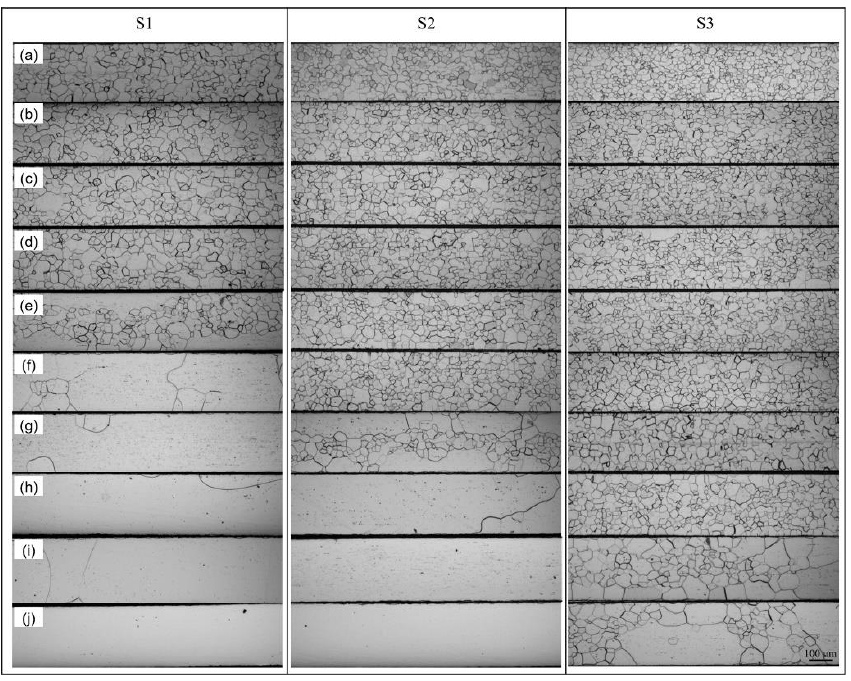
Figure 1. The metallography of the extracted samples during high temperature annealing. ( a ) 25 °C, ( b ) 850 °C; ( c ) 900 °C; ( d ) 980 °C; ( e ) 1000 °C; ( f ) 1010 °C; ( g ) 1020 °C; ( h ) 1030 °C; ( i ) 1040 °C; ( j ) 1200 ( b ) 850 ◦ C; ( c ) 900 ◦ C; ( d ) 980 ◦ C; ( e ) 1000 ◦ C; ( f ) 1010 ◦ C; ( g ) 1020 ◦ C; ( h ) 1030 ◦ C; ( i ) 1040 ◦ C; °C. ( j ) 1200 ◦